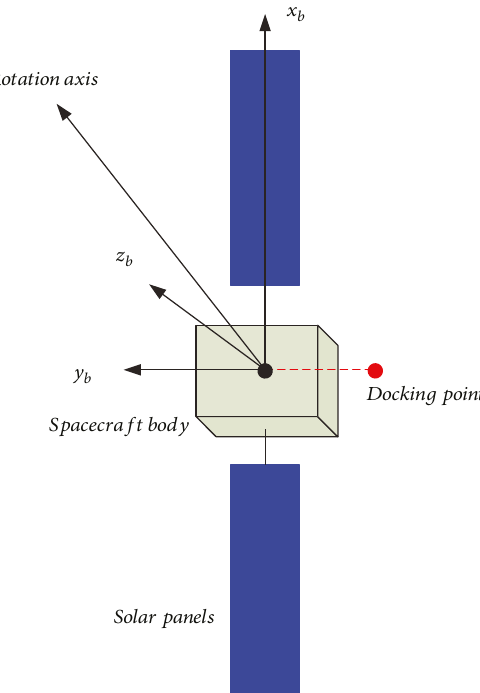
Figure 2: Failed spacecraft with two mounted solar panels.